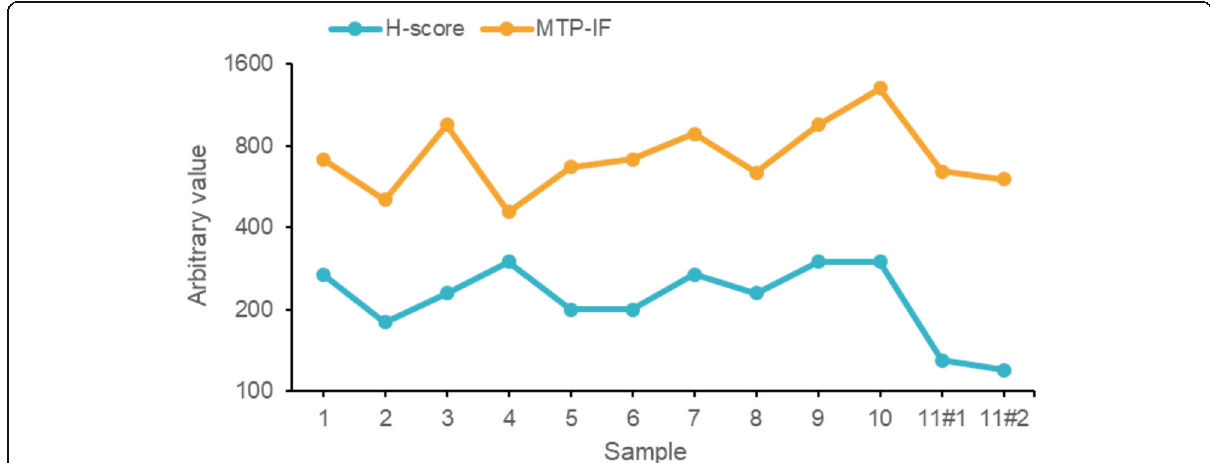
Fig. 5 Correlation of the ALK MTP-IF values with chromogenic IHC. Graphical visualisation of the “ H-score ” (blue) and “ MTP-IF ” (orange) values for ALK staining on 12 ALK-positive lung ADC. Sample 11#1 and 11#2 represent two specimens with distinct localization (lung primary and parietal pleura, respectively) from the same patient (Case